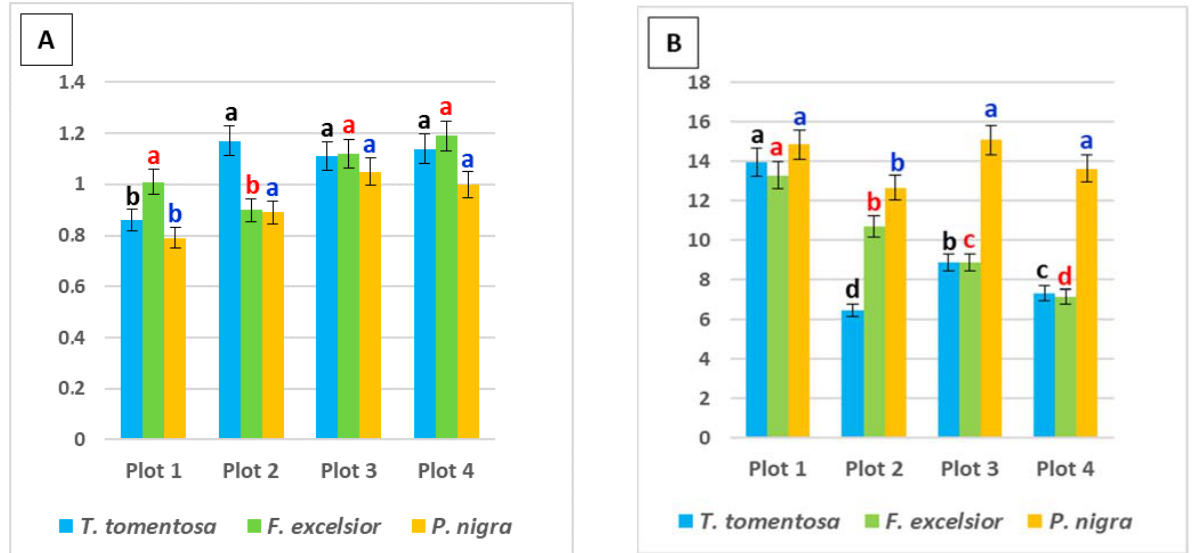
Figure 3. Ratio between photosynthetic pigments in the leaves of studied tree species, planted in four urban plots with different types and intensity of anthropogenic impact: ( A ) chlorophyll a/chlorophyll b; ( B ) total chlorophyll/carotenoids. For each tree species ( Tilia tomentosa in black, Fraxinus excelsior in red; Pinus nigra in blue), means showing different letters are significantly different according to Student’s LSD comparison test ( p < 0.05).